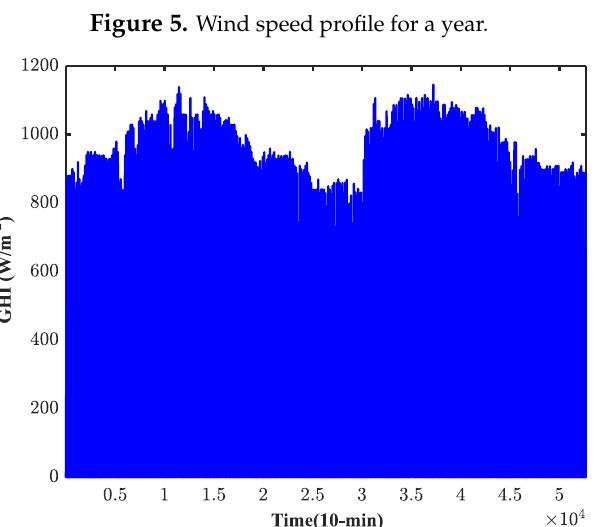
Figure 6. Global horizontal irradiance for a